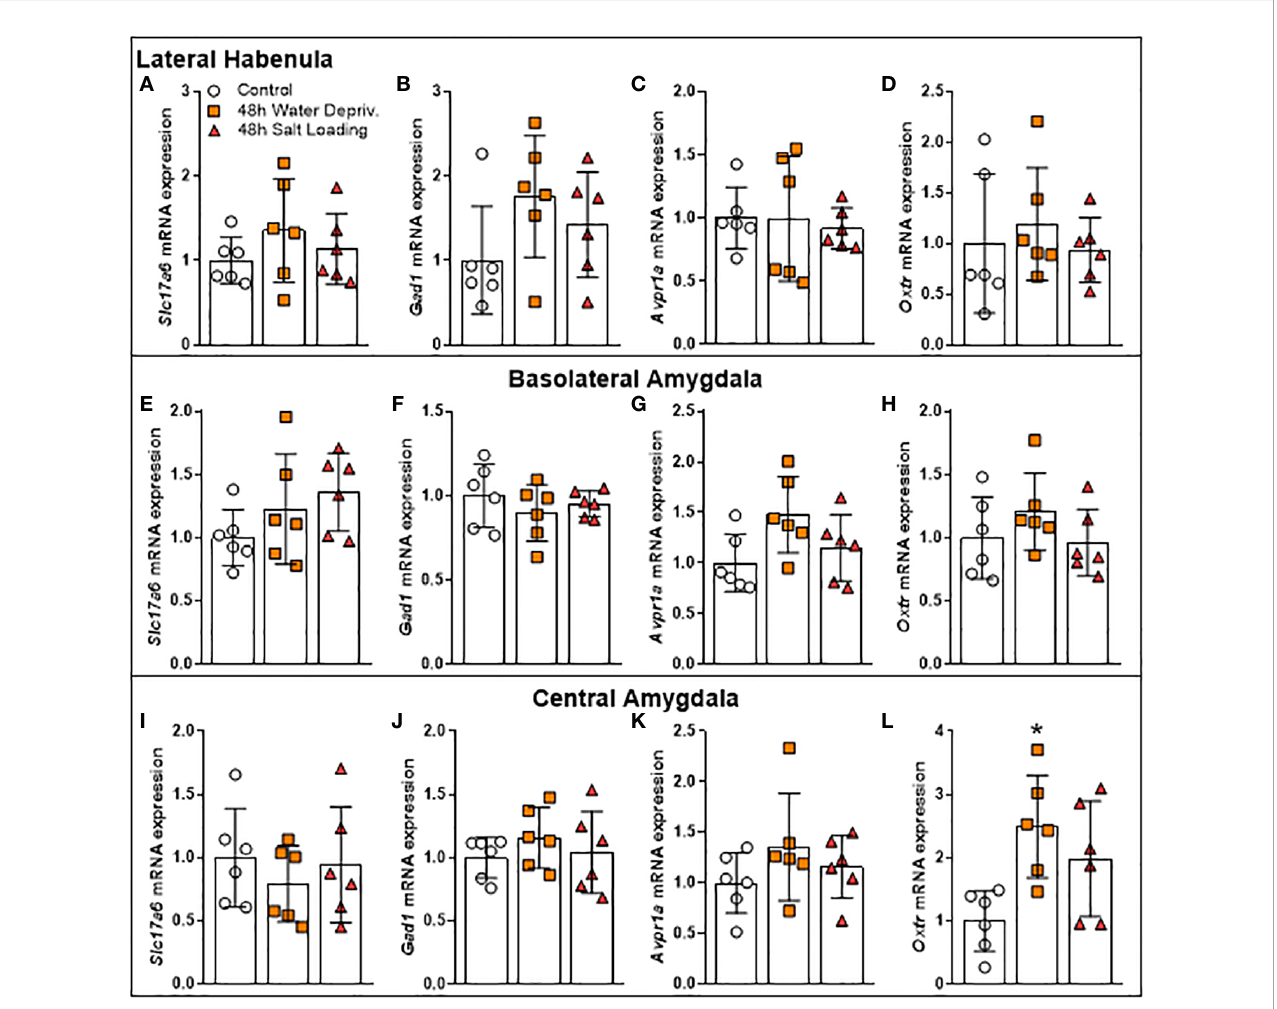
FIGURE 5 Effects of 48 h of dehydration in male adult rats on relative mRNA expression of (A, E, I) the Vesicular Glutamate Transporter 2 ( Slc17a6 ), (B, F, J) the Glutamate Decarboxylase 1 ( Gad1 ), (C, G, K) the Arginine Vasopressin Receptor 1A ( Avpr1a ), and (D, H, L) the Oxytocin Receptor ( Oxtr ) in the (A – D) lateral habenula, (E – H) the basolateral amygdala (BLA), and (I-L) the central amygdala (CeA). Values are mean ± SD of 6 animals per group. Data of gene expression in BLA as well as Oxtr mRNA expression in CeA were analyzed by one-way ANOVA followed by the Tukey post hoc test. The other data were submitted to the Kruskal-Wallis test. *p<0.05 compared to the control